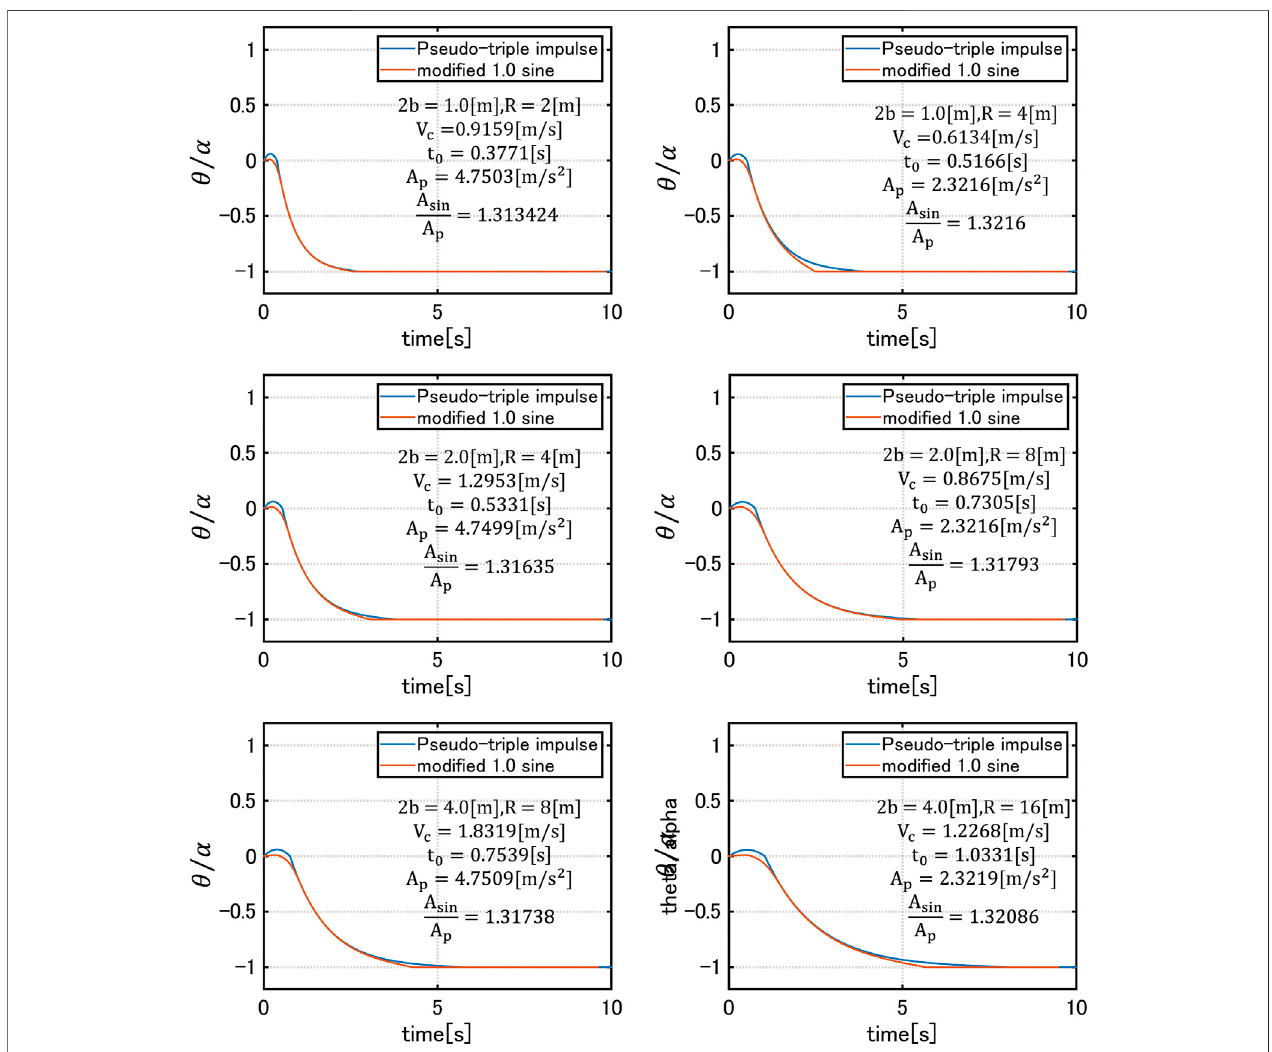
FIGURE8| Comparisonoftime-historyresponses θ ( t )/ α atoverturninglimitbetweenthepseudo-tripleimpulse,consistingofthe fi rsttwoimpulsesintripleimpulse, and the corresponding equivalent modi fi ed 1.0-cycle sinusoidal wave magni fi ed by a coef fi cient about 1.31 – 1.32.